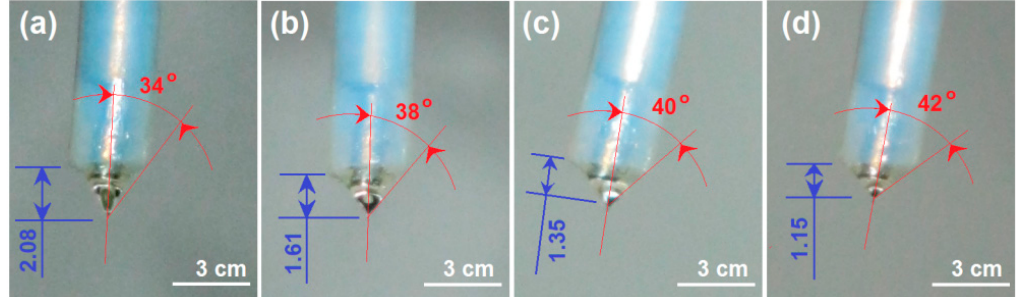
Figure 3. The typical changes of Taylor cone with the elevation of applied voltages (kV): ( a ) 13; ( b ) 14; ( c ) 15; ( d ) 16.